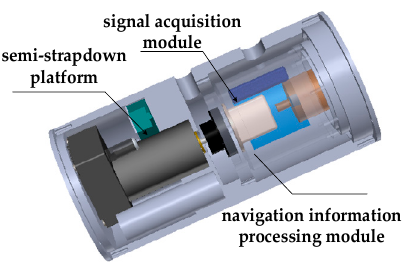
Figure 1. The structure of strapdown inertial navigation system (SINS).